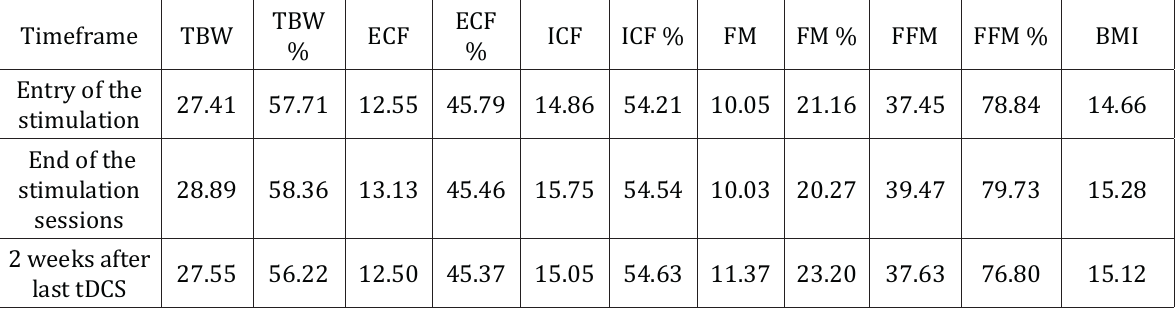
Table 5. Changes in anthropometric measures during